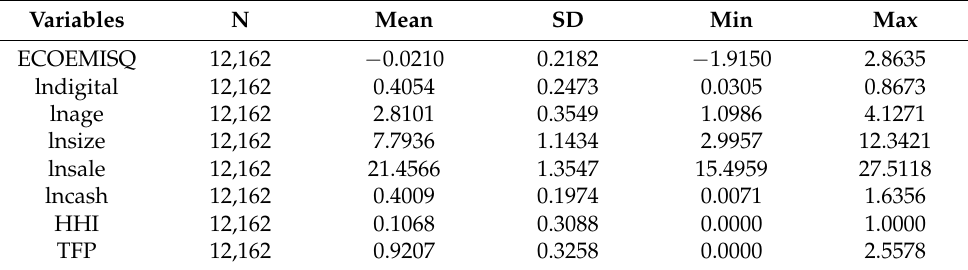
Table 2. Descriptive statistics of